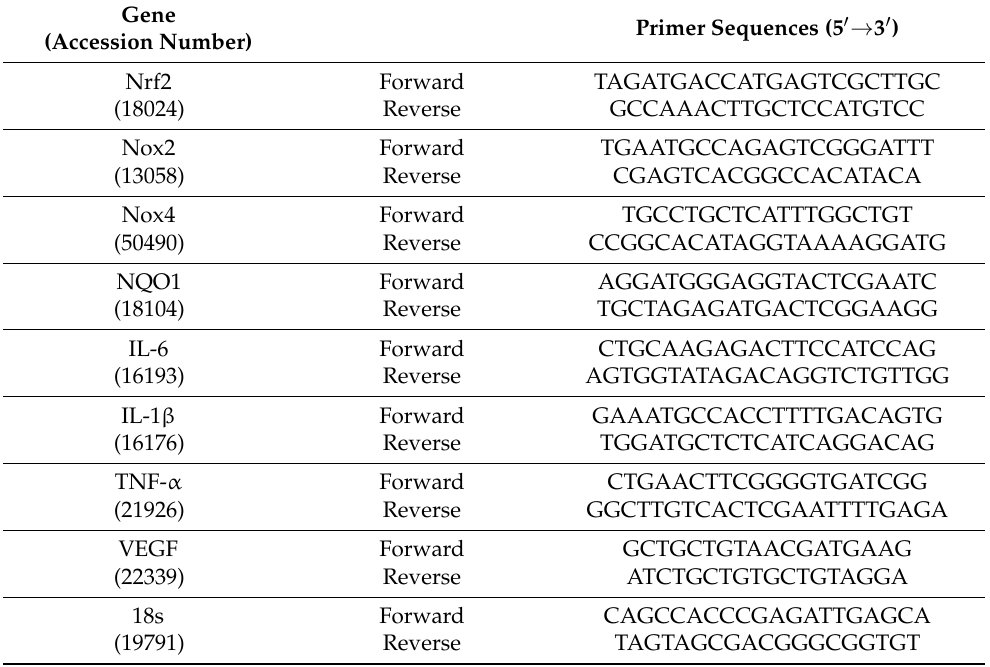
Table 1. List of Primer